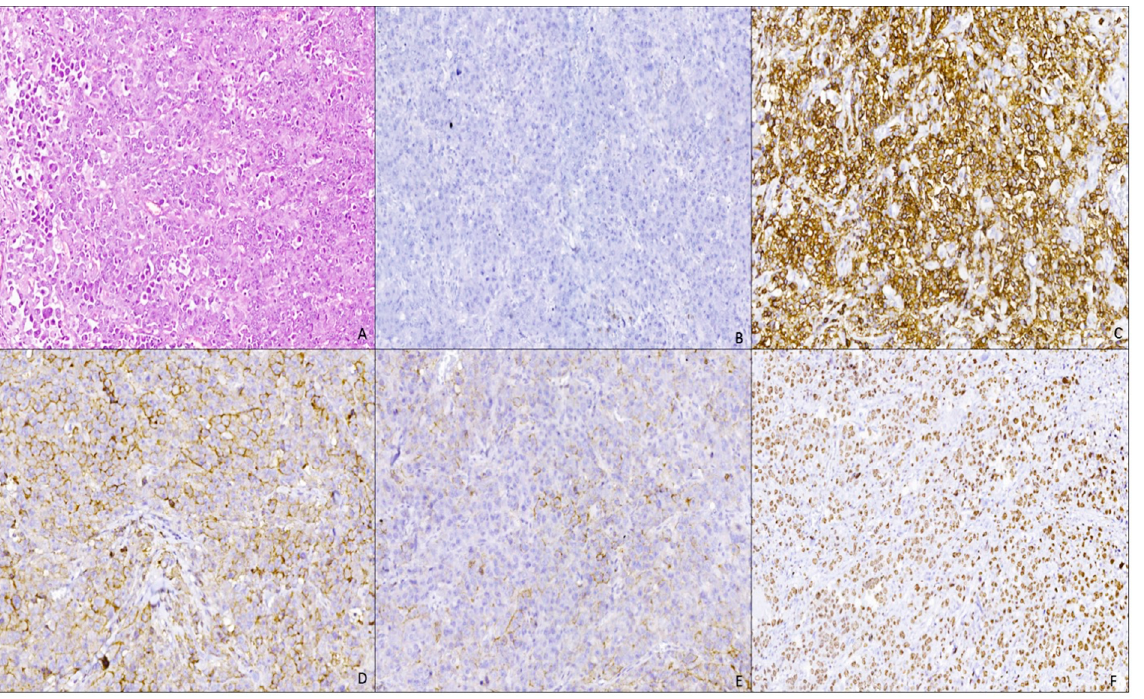
Figure 2. Plasmablastic lymphoma of the oral mucosa: ( A ) proliferation of large atypical cells with immunoblastic features (H&E stain, Ob. ×100); ( B ) negative immunostain for CD20 antibody (IHC, Ob. ×100); ( C ) intense and diffuse membranous immunostaining for CD38 antibody (IHC, Ob. ×100); ( D ) moderate and diffuse membranous and cytoplasmic immunostaining for Kappa antibody (IHC, Ob. ×100); ( E ) moderate and focal membranous and cytoplasmic immunostaining for lambda antibody (IHC, Ob. ×100); ( F ) intense and diffuse nuclear immunostaining for KI67 antibody, with a high KI67 index of − 90% (IHC, Ob. ×100).